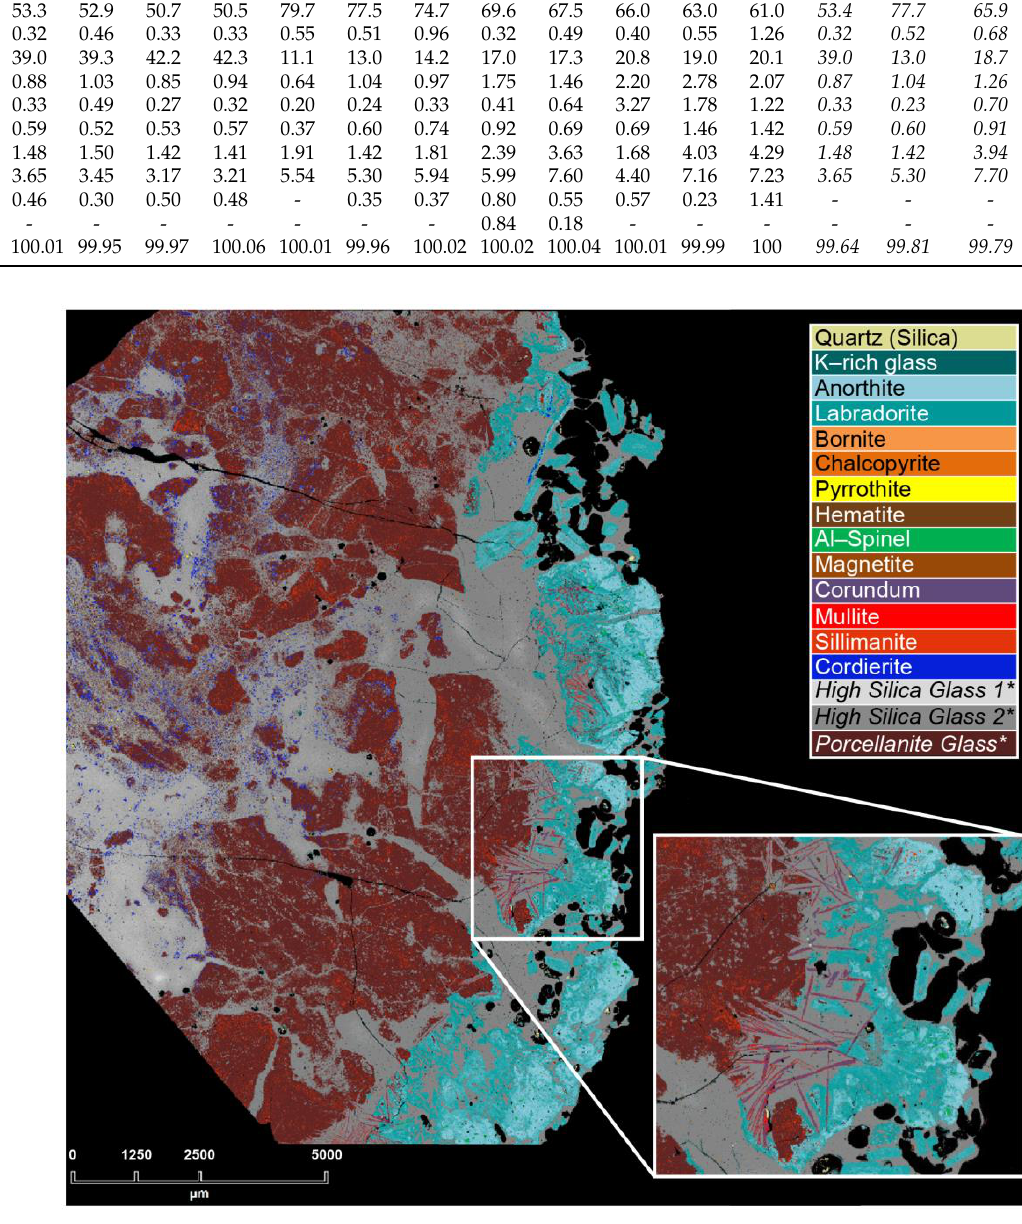
Figure 4. A large (1.25 cm × 1.75 cm) QEMSCAN TM area (step from one pixel to the next is 4.8 μm) of the composite porcellanite–buchite xenolith (B1). The inset highlights the acicular needles that change from corundum to mullite, Al– spinel and high An% plagioclase + glass marking the contact between the xenolith ( left ) and the LP–HP basaltic magma (to the right , not present in this figure). The anorthite–labradorite colour indices provide the plagioclase composition between these end-members for both phenocrysts and